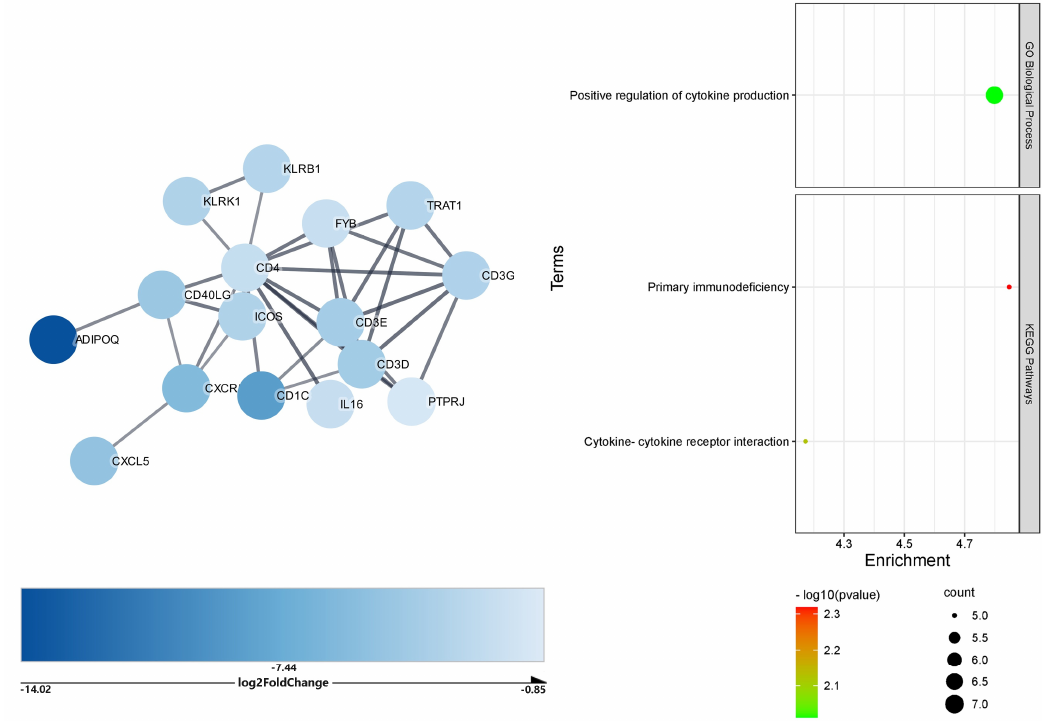
Figure 4. Cluster and functional enrichment analysis of COVID − 19 lymph node downregulated DEGs targeted by upregulated microRNAs. STRING interaction confidence score > 0.7; Markov clustering inflation value = 4; STRING Enrichment FDR < 0.05; redundancy score = 0.5. In the kidneys, the downregulated DEGs impacted by the upregulated microRNAs formed a network with 717 genes and 421 nodes. After Markov clustering, the largest cluster contained 87 nodes and 153 edges (PPI = 1 × 10 − 16 ); its enrichment analysis identified the cell-surface receptor signaling pathway (33 genes) and KEGG pathway proteoglycans in cancer (14 genes) as most significantly impacted by microRNAs (Figure 5A). The upregulated DEGs targeted by downregulated microRNAs formed a complex network of 923 nodes with 1728 edges. The results of Markov analysis showed that the largest cluster contained 27 nodes with 130 edges (PPI = 1 × 10 − 16 ), and enrichment analysis identified the mitotic cell cycle (16 genes) as the most significantly impacted biological process (Figure 5B).